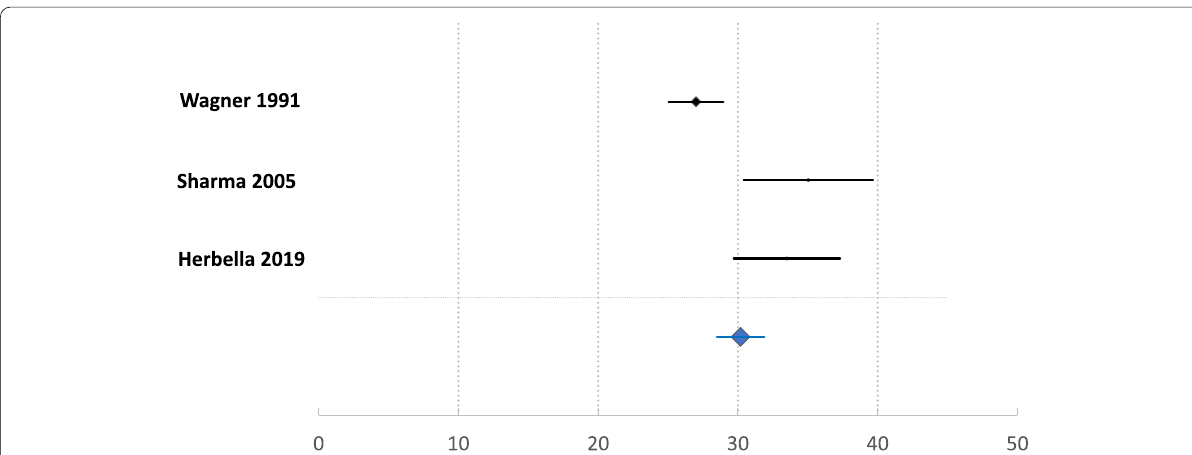
Fig. 1 Lymph node counts for D2 lymphadenectomy. Mean numbers of lymph nodes (individual studies and pooled) and their 95% confidence intervals. Size of dots represents number of cadavers examined